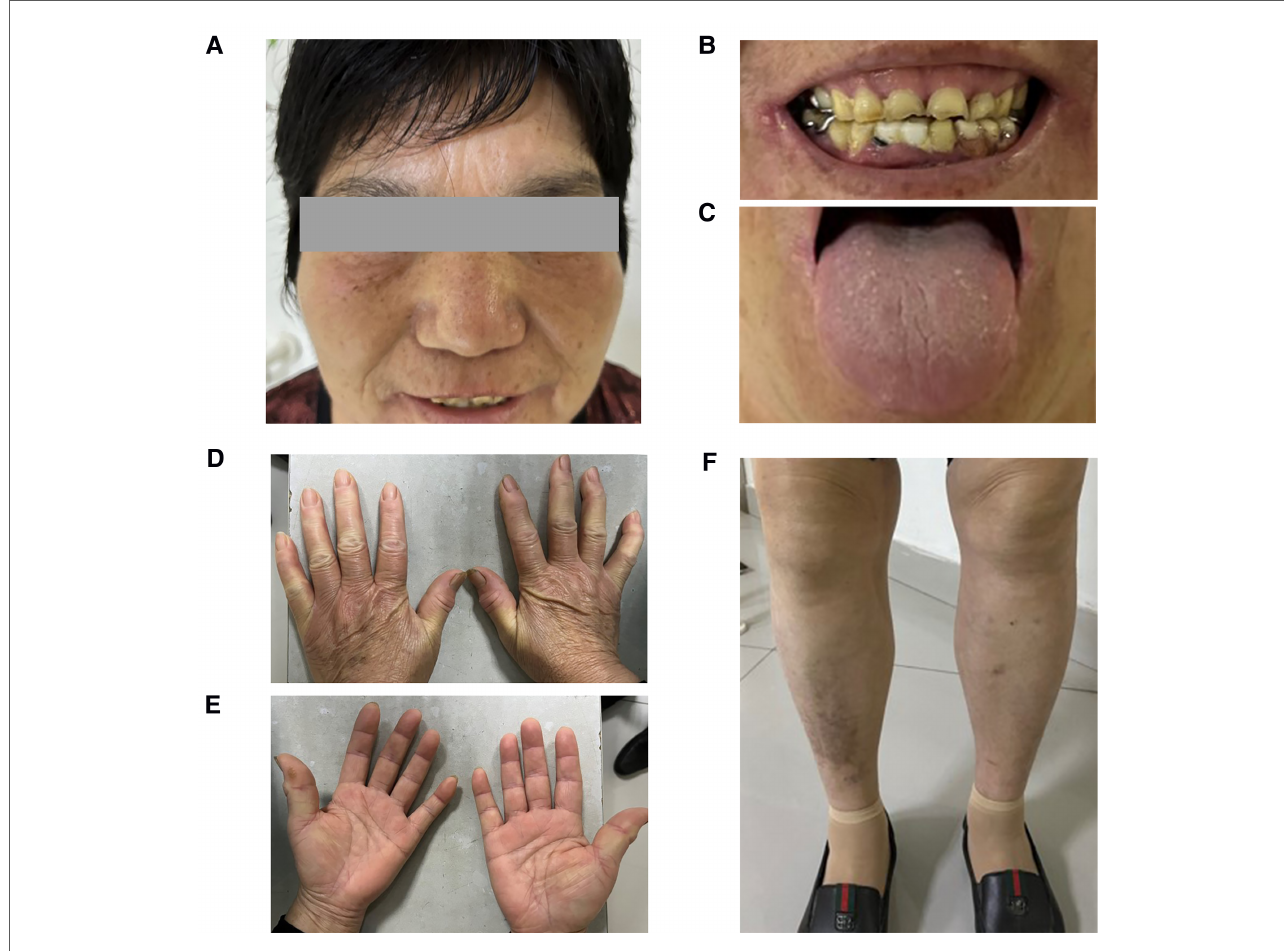
FIGURE 1 The patient ’ s clinical